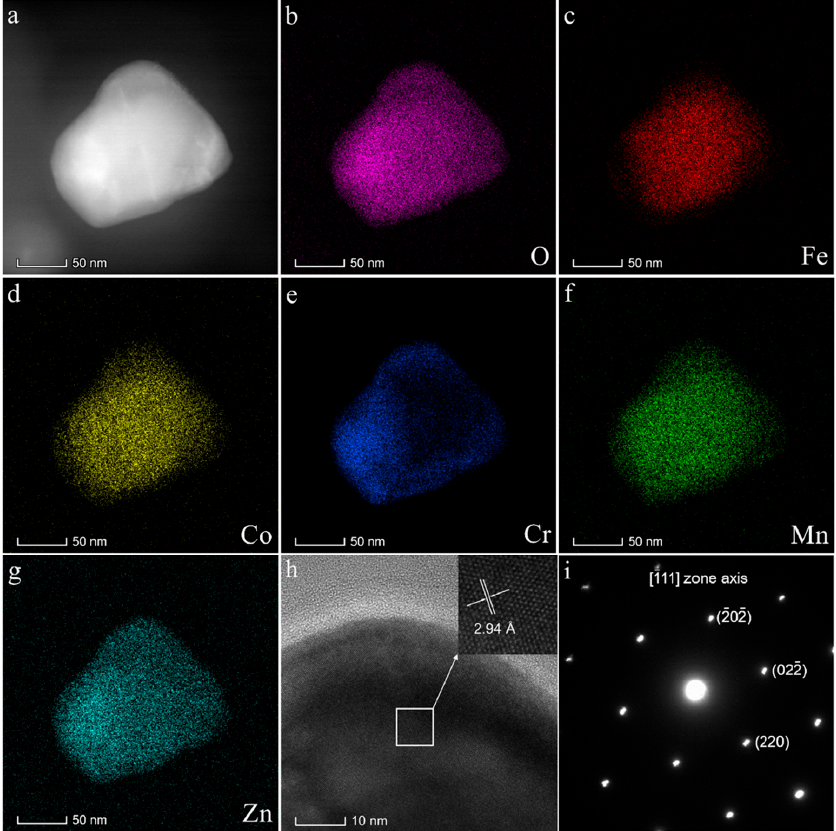
Figure 3. Characterization of (FeCoCrMnZn) 3 O 4 powder: ( a ) STEM image, ( b – g ) energy-dispersive X-ray spectroscopy (EDS) analysis of O, Fe, Co, Cr, Mn, Zn, ( h ) high-resolution transmission electron microscope (HR-TEM) image, and ( i ) corresponding fast Fourier transform (FFT) pattern aligned along the [ 111 ] zone axis.